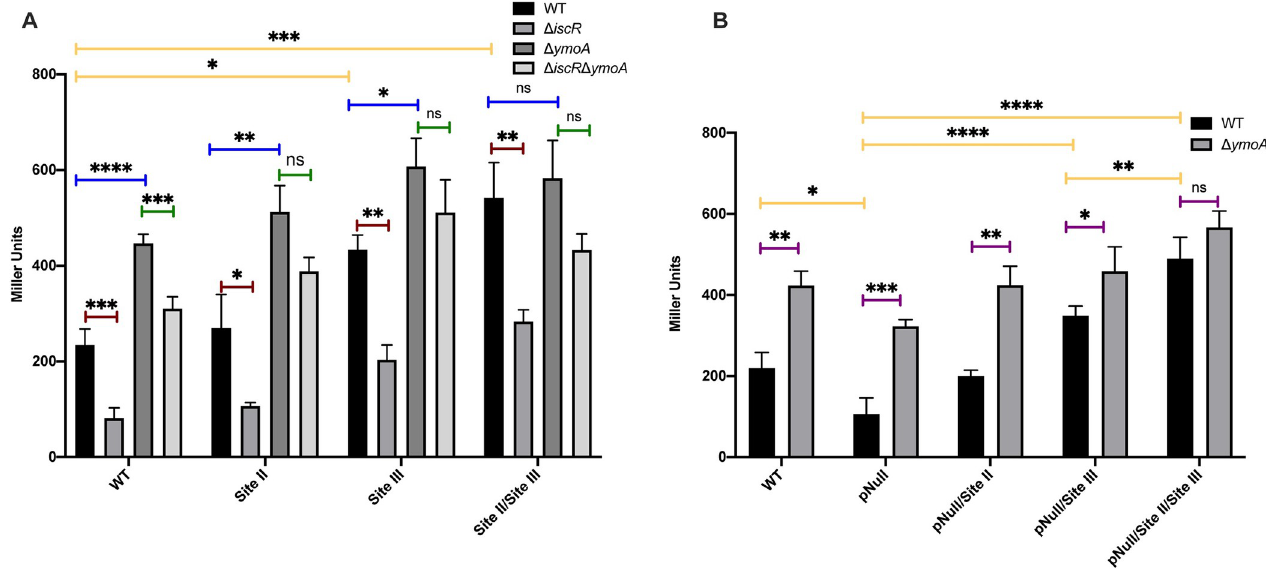
Fig 4. The AT-rich Sites II and III bound by H-NS are necessary for YmoA-dependent repression as well as IscR potentiation of yscW-lcrF promoter activity. (A) The pyscW-lcrF :: lacZ reporter 2 construct from Fig 3 was used as a template to generate pyscW-lcrF :: lacZ promoter fusions with H-NS Site II and III mutations, and the mutated promoters introduced into the WT, Δ iscR , Δ ymoA , and Δ iscR / Δ ymoA Y . pseudotuberculosis genetic backgrounds. (B) Additionally, pyscW-lcrF :: lacZ reporter 2 constructs carrying WT or mutated Site II and/or III were further mutated for the IscR binding site (pNull) and introduced into WT and Δ ymoA Y . pseudotuberculosis . All these strains were grown aerobically under T3SS-inducing conditions (low calcium LB at 37˚C) for 1.5 hrs and assayed for β -galactosidase (Miller units). The different promoter constructs are listed on the x-axis. The average of at least three biological replicates are shown ± standard deviation. Statistical analysis was performed using (A-B) a one-way ANOVA with Bonferroni’s multiple comparisons test on either (yellow bars) all WT genetic backgrounds carrying different reporter constructs or (blue, green, or red bars) each individual reporter construct expressed in WT, Δ iscR , Δ ymoA , or Δ iscR / Δ ymoA ; or (B) an unpaired t test (purple bars). ( � p < .05, �� p < .01, ��� p < .001, ���� p < .0001, and n.s.